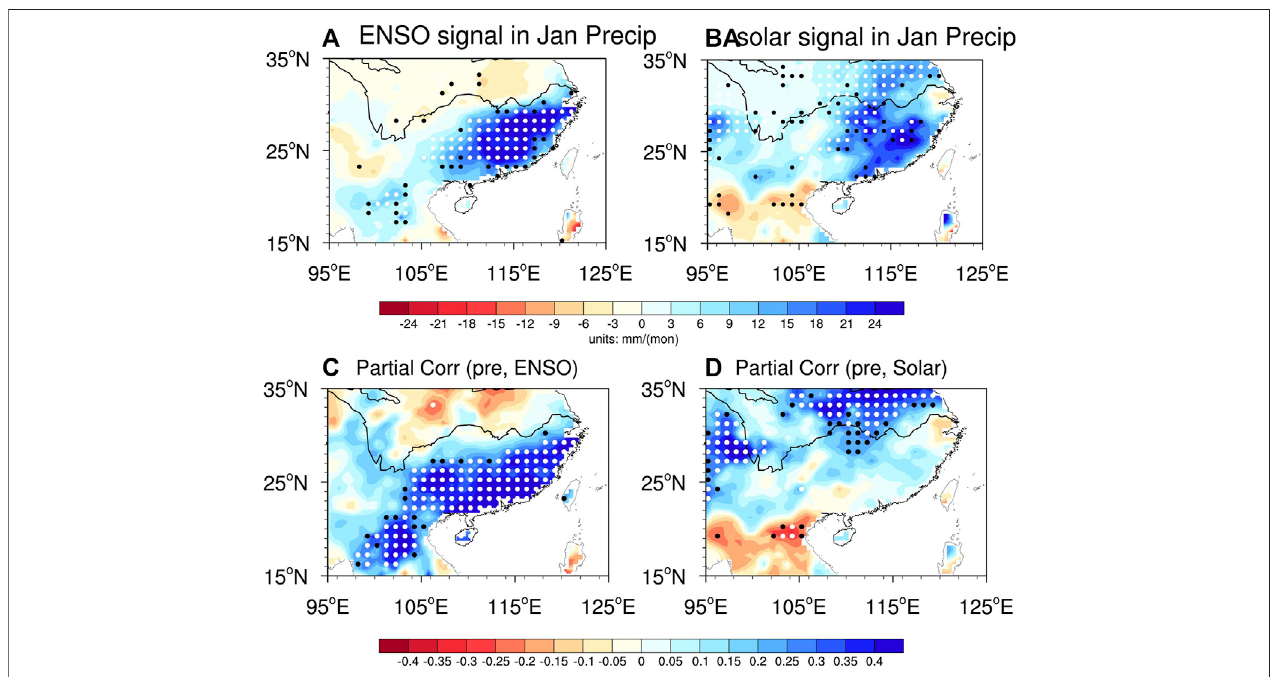
FIGURE 2 | The estimated ENSO panel (A) and solar panel (B) signals in the mid-winter (January) precipitation obtained using MLR in Eq. 1 for the period 1948 – 2016. The ENSO/solar signals are de fi ned as the MLR coef fi cients of ENSO/SSN multiplied by two standard deviation of the index, thus the units of these signals are mm/mon. panel (C) shows the partial correlation coef fi cients between the precipitation and the ENSO with solar effect excluded, panel (D) shows the partial correlationcoef fi cientsbetweentheprecipitationandthesolarwithENSOeffectexcluded.Solidblack(white)dotsdenoteregionswherethesignalsarestatistically signi fi cant at the 10% (5%) level [i.e., p < 0.1 ( p <